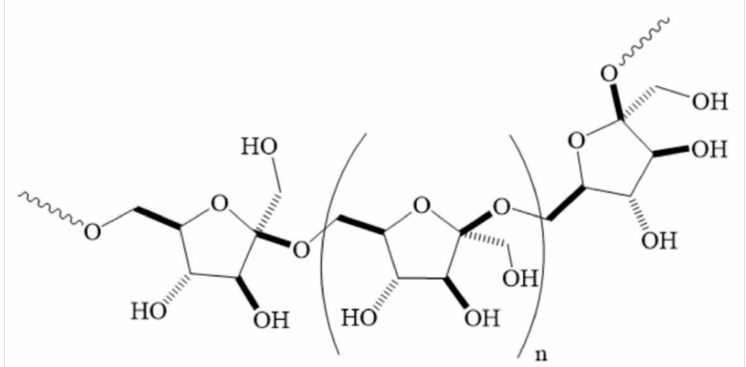
Figure 1. Structure of